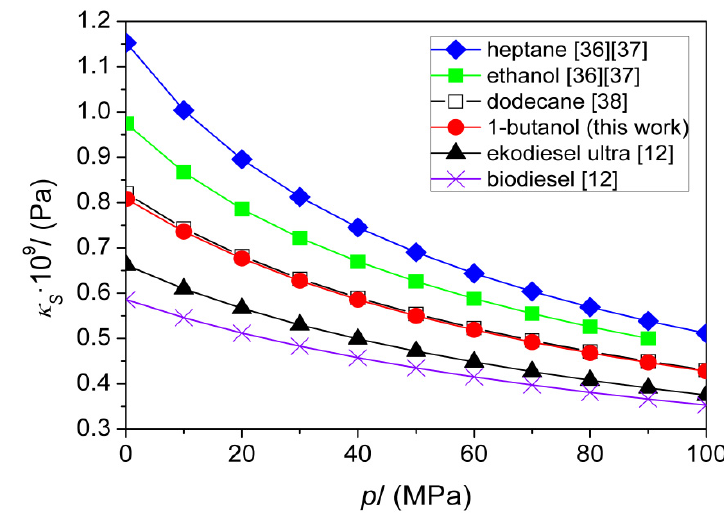
Figure 14. The pressure dependence of isentropic compressibility of heptane and dodecane—fuel components, ethanol—the most common used bioalcohol, low sulfur diesel oil (ekodiesel ultra) and biodiesel (FAME) at 298.15 K.